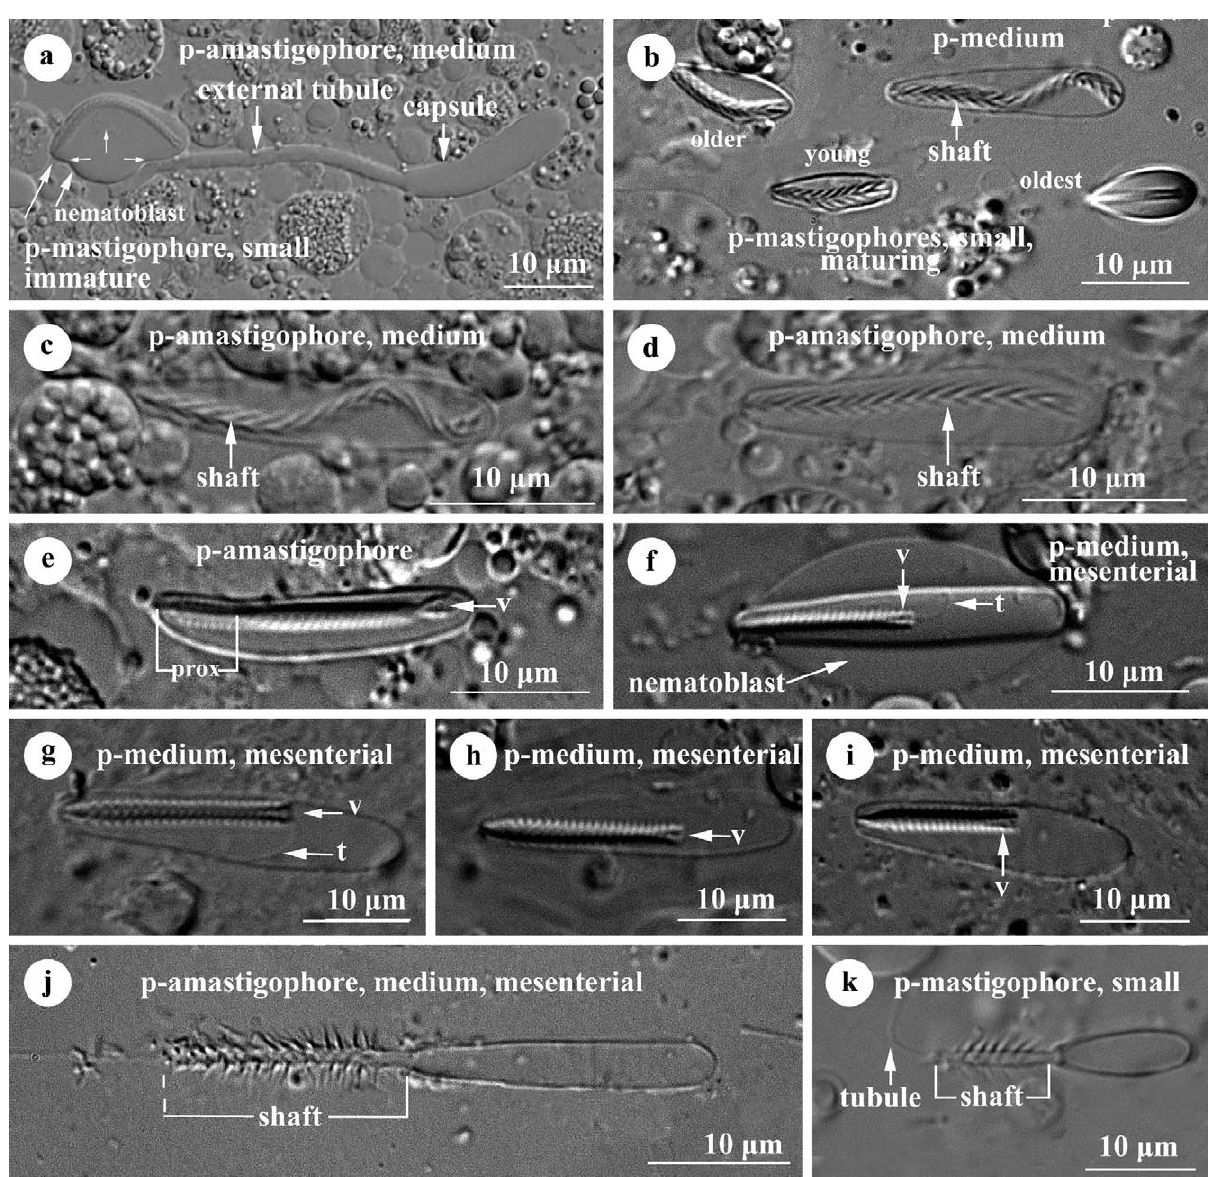
Fig . 7. – Stages in differentiation of mesentery p-amastigophores and p-mastigophores. a) To right a p-amastigophore, medium; early in development with external tubule. To left an immature p-mastigophore, small, drop-shaped, showing inverted shaft and nematoblast. Border between capsule and nematoblast faintly seen (tiny arrows). b) 3 p-mastigophores, small drop-shaped (most differentiate to right) and a p- amastigophore, medium. Note V-shaped spine pattern. c,d) p-amastigophores, medium, showing V-shaped spine pattern. V-shaped notch at shaft end not developed. e) p-amastigophore, medium; proximal and main shaft distinct (see Fig. 6d). Proximal shaft with dense helices. Main shaft with spaced helices and V-notch. f,g,h.i) p-amastigophores, medium, mesenterial; late differentiation. The shaft shortens within capsule as its helices tighten. j) Discharged p-amastigophores, medium, mesenterial. Shaft end slightly damaged. k) Discharged p-mastigophore, small drop-shaped. p-medium , p-amastigophore medium; t , tubule; prox, proximal shaft; v , V-shaped